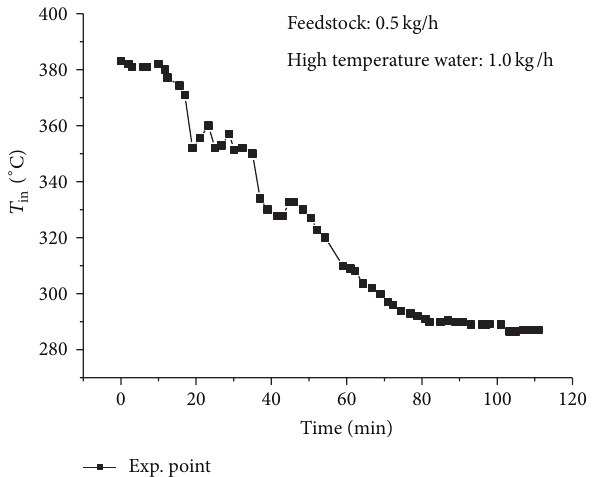
Figure 3: The variation of fluid temperature at the reactor inlet with time (small flow high temperature water).